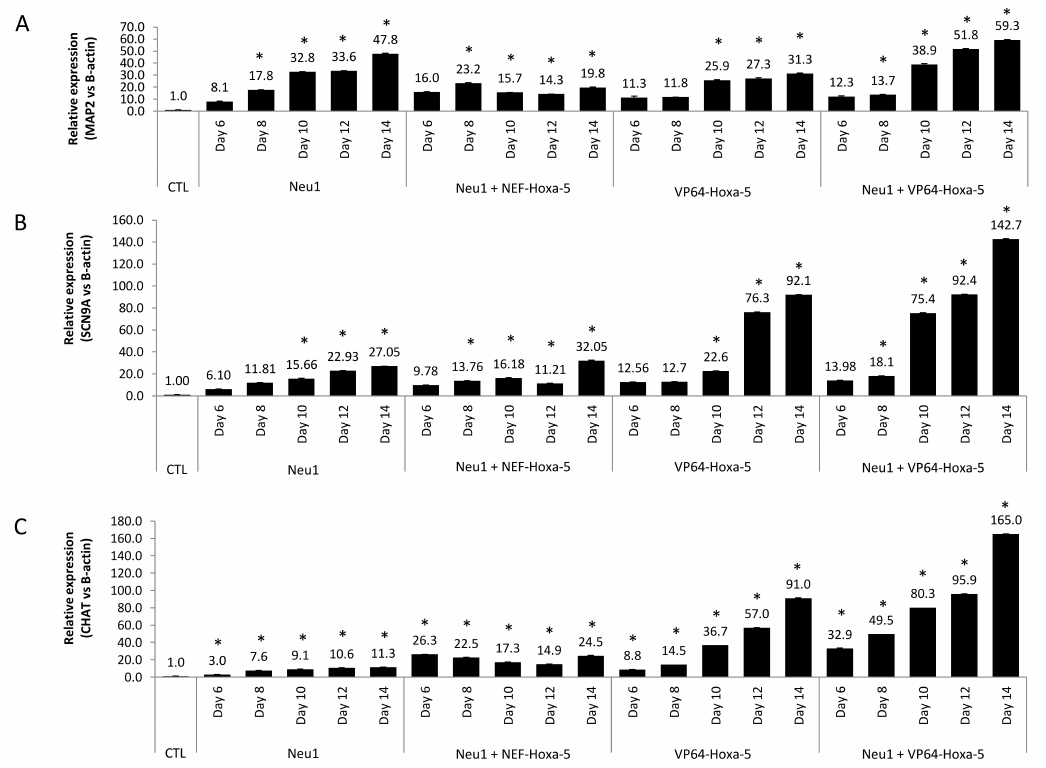
Figure 7. Modulation of neuronal markers in inducible hASCs generated by a CRISPR/dCas9 system. The use of a CRISPR/dCas9 system allowed to obtain hASCs with overexpressed Hoxa-5 gene (VP64-Hoxa-5). NEF-Hoxa-5 cells (obtained with a non-functional CRISPR system) and hASCs were used as controls (see Section 2). All cells were exposed to Neu-1 (6, 8, 10, 12, and 14 days) to analyze the potentiation effect of the neural differentiation process. Quantitative RT-PCR was used to evaluate the expression of MAP2 ( A ), SCN9A ( B ), and CHAT ( C ) markers in VP64-Hoxa-5 and VP64-Hoxa-5 exposed to Neu1 media. hASCs exposed to Neu1 media was used as a control. In addition, NEF-Hoxa-5 cells exposed to Neu1 media was also used as a control. Statistically significant differences (*) with respect to the control ( p ≤